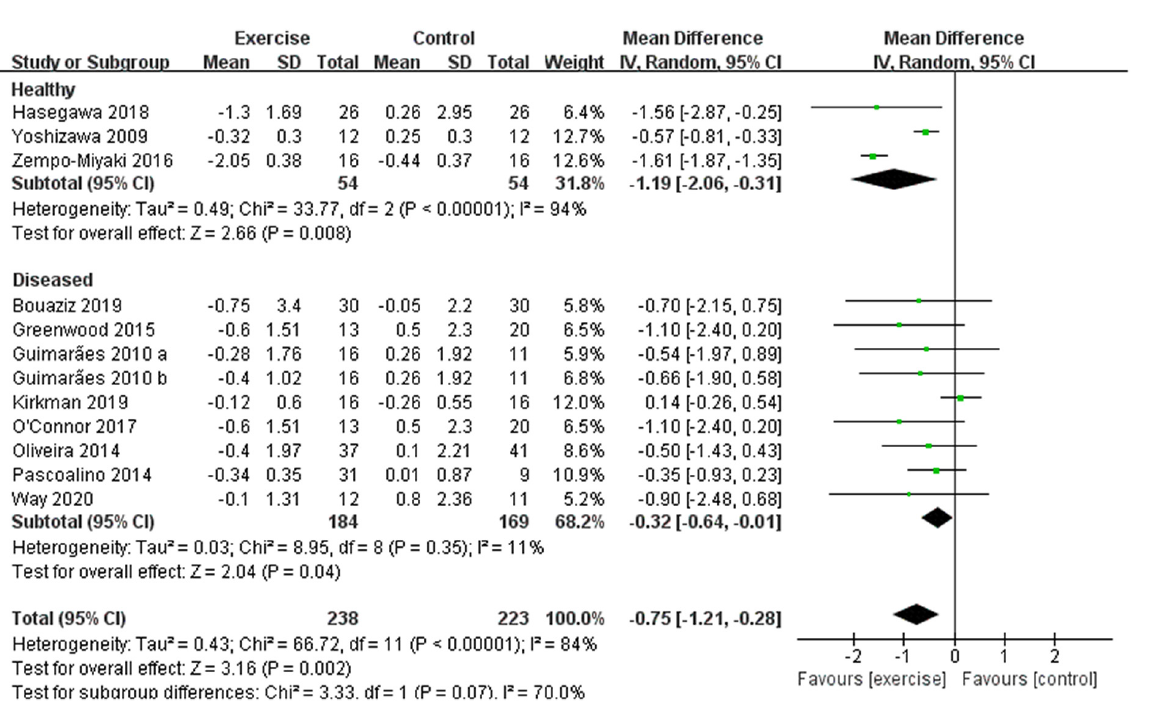
FIGURE7 Meta-analysis results of the effect of aerobic exercise on the PWV of healthy or diseased middle-aged and elderly people. The pooled estimates were obtained from random effects analysis. Diamonds indicate the size of the effect of each study summarized as WMD. The size of the shaded square is proportional to the percentage weight of each study. Horizontal line represents the 95% CI and the vertical dashed line represents the overall